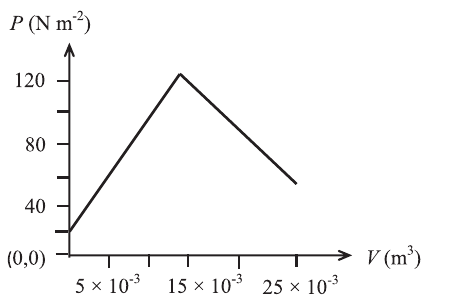
FIG. 4. Pressure-volumegraph requestinga